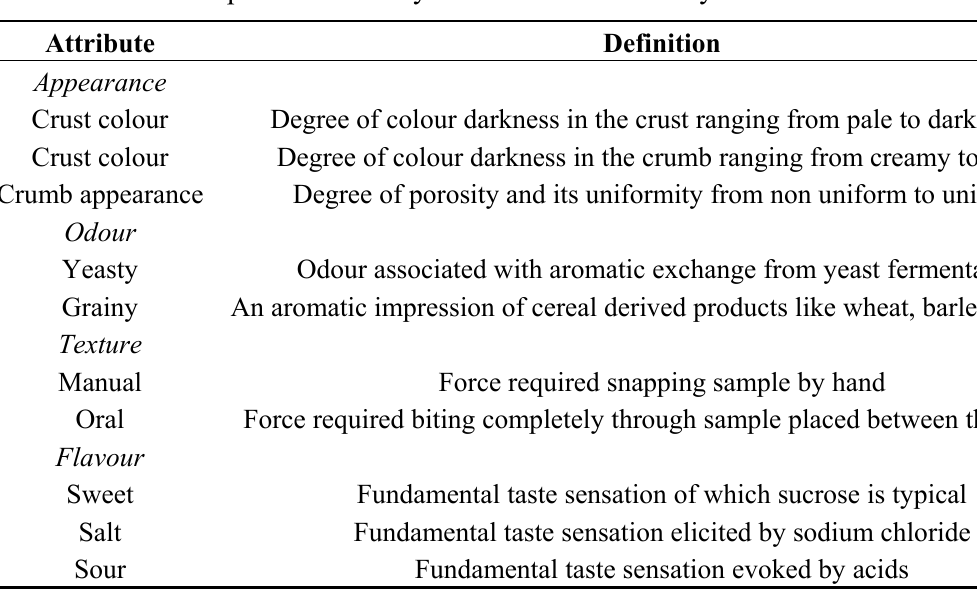
Table 2. Descriptive vocabulary and definitions used by assessors to evaluate